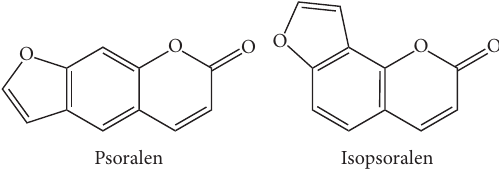
Figure 1: Chemical structures of psoralen and